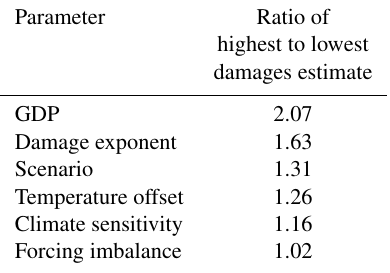
Table 1. Parameter sensitivity analysis: examining the sensitivity of the GWP–discount rate equivalency as shown in the uncertainty ranges in Fig. 2 as a function of the individual parameters of the calculation. The ratio is calculated as the ratio of the median of the estimated GWPs given the highest and lowest value of each param- eter. The results in this table are derived assuming a discount rate of